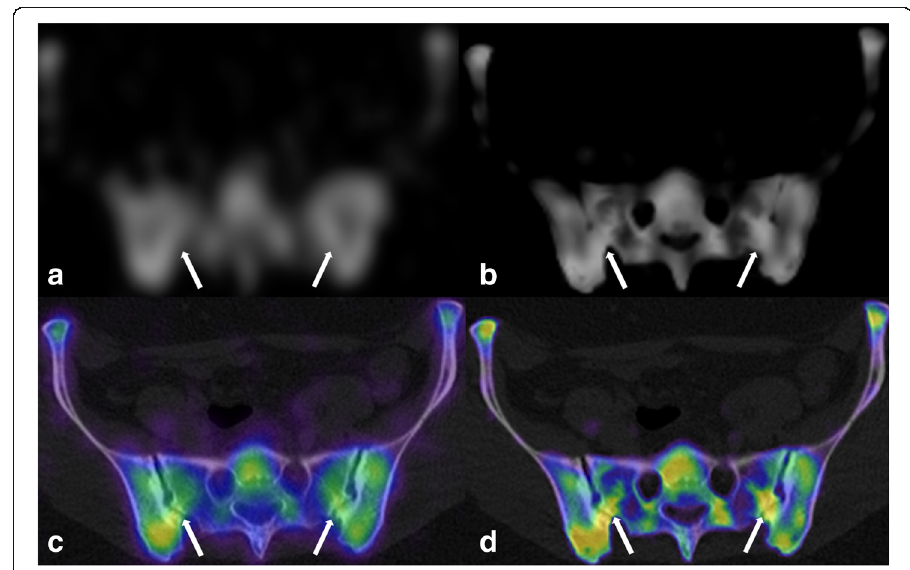
Fig. 7 Osteoarthritis Left Posterior Sacroiliac Joints. Detailed Legend: 35 yr. old female with lower back pain and degenerative changes in posterior synovial sacroiliac joints (white arrows). Single transaxial slice (all same slice): a SPECT, b xSPECT, c SPECT-CT, and d xSPECT-CT. Note the difficulty in identifying any abnormality in the SPECT slice ( a